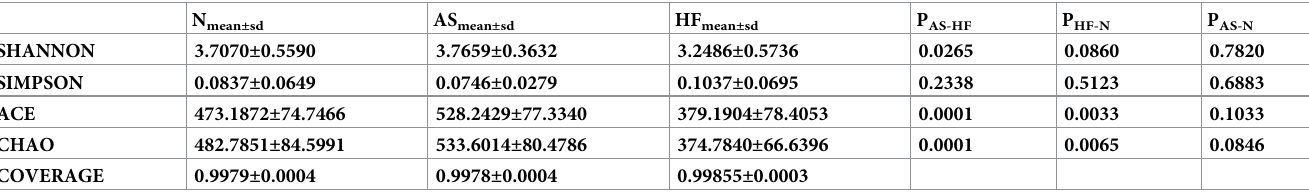
Table 1. The Alpha diversity analysis of microbiome in